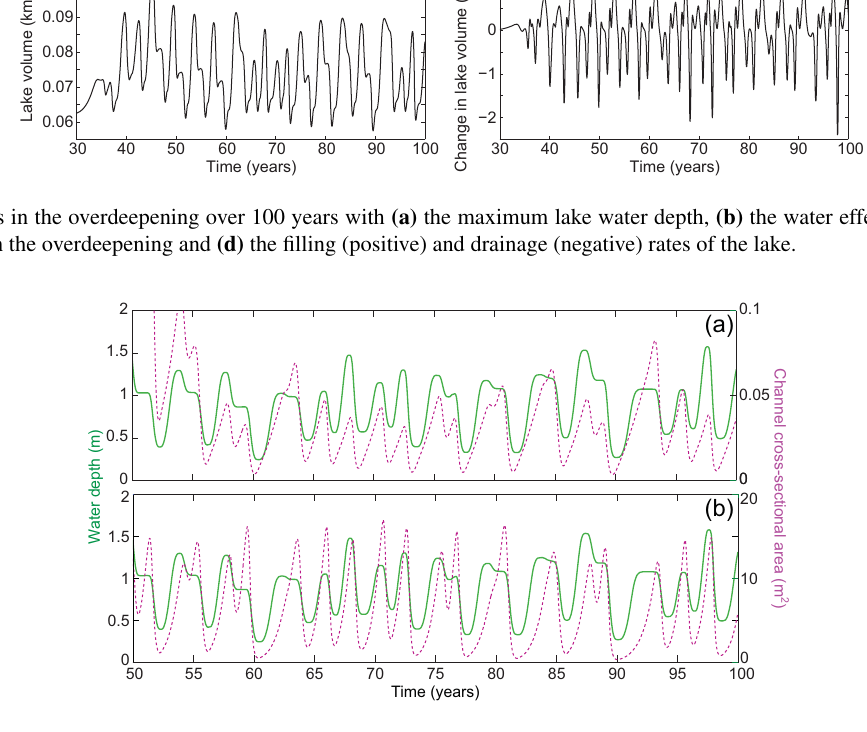
Figure 7. Maximum lake depth (green) and conduit cross-sectional area (purple dashed) at (a) the rim of the overdeepening adverse slope and (b) 10km downstream from the overdeepening rim, over 50 years. Lake depth is the same in each plot for direct comparison with channel